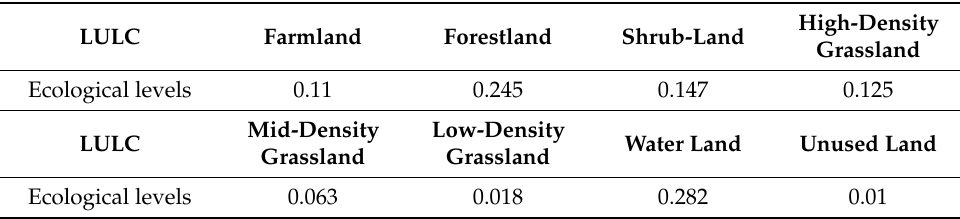
Table 1. Ecological level of the di ff erent land use